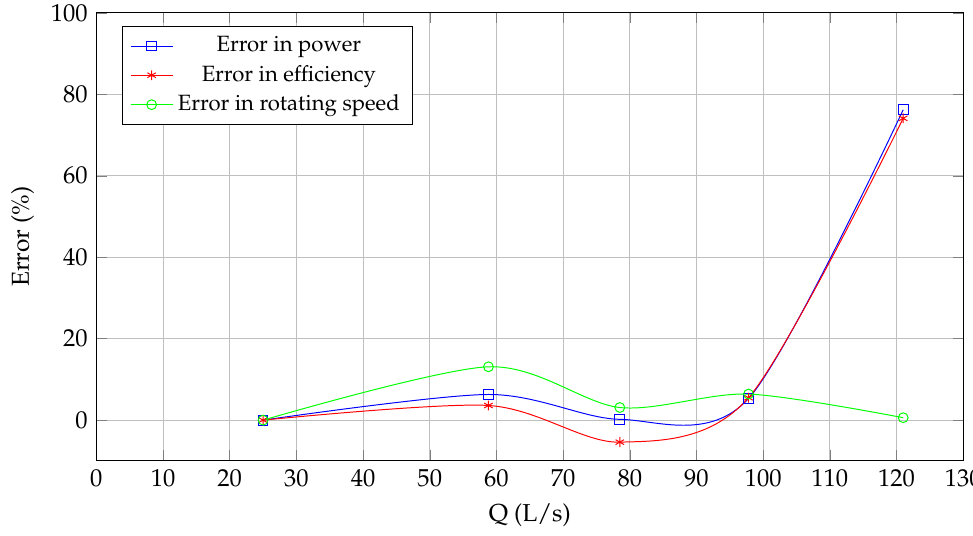
Figure 17. Comparison errors for various